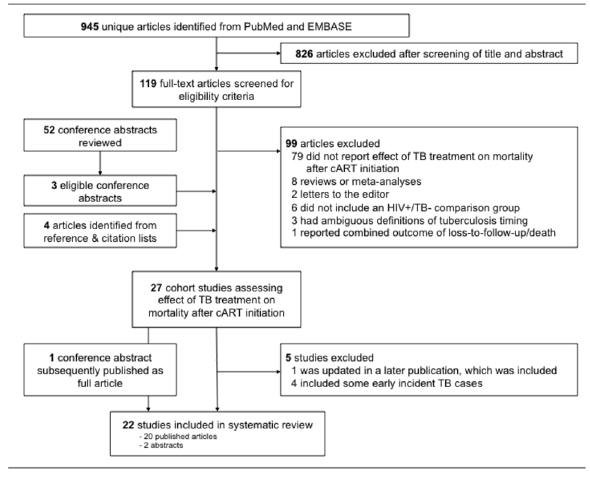
Figure 1. Identification and selection of